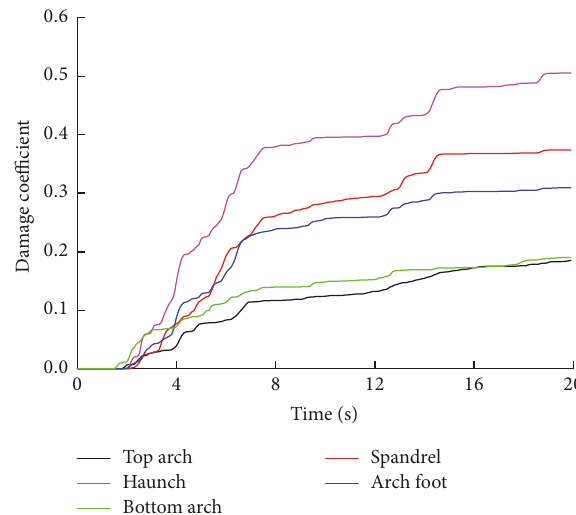
Figure 10: Damage coefficients variation time-history of monitor- ing points.